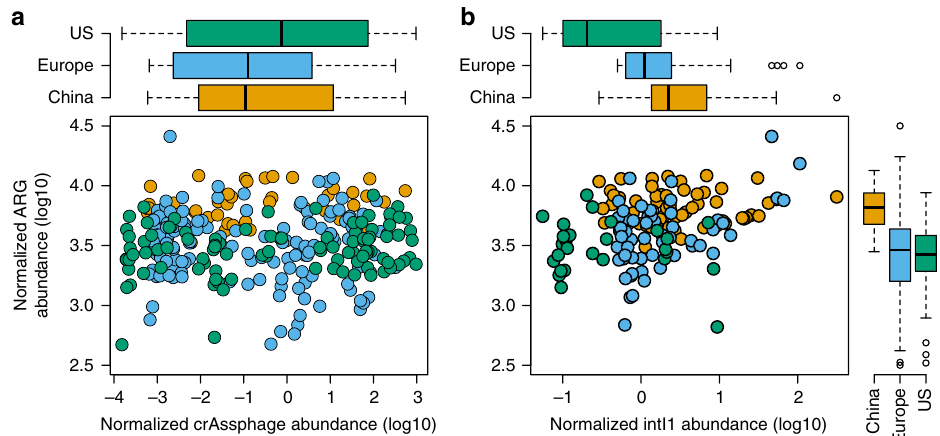
Fig. 1 Abundance of antibiotic resistance genes, intI1 gene and crAssphage in human fecal metagenomes. Mobile antibiotic resistance gene abundance in relation to crAssphage ( a ) and intI1 gene ( b ) abundance in studied human fecal metagenomes from 35 and Integrative Human Microbiome Project (iHMP). We found no correlation between the total mobile ARG abundance and crAssphage abundance in human fecal metagenomes con fi rming the independence of the abundance of mobile ARGs from crAssphage abundance. In boxplots the lower hinge represents 25% quantile, upper hinge 75% quantile, and center line the median. Notches are calculated with the formula median ± 1.58 × interquartile range/sqrt ( n